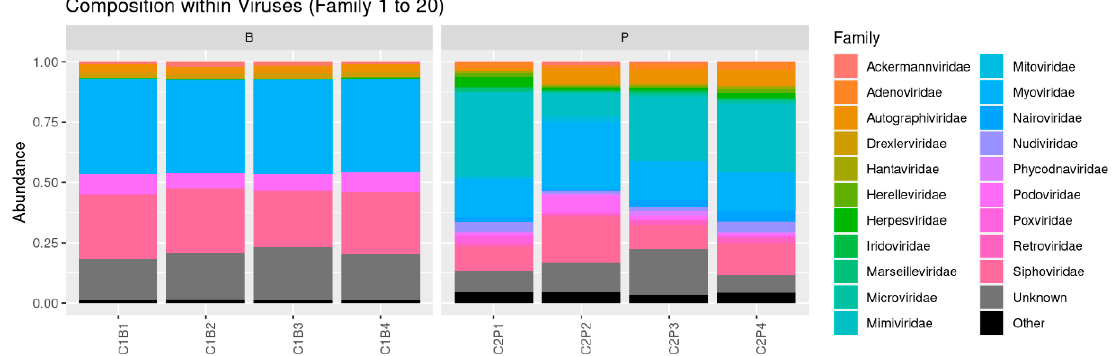
Figure 2. Virus taxonomic assignations at the family level during cider fermentation process for two producers (B: industrial and P: hand-crafted). C1 and C2 indicate the tank ID, and B1, B2, B3, B4, P1, P2, P3 and P4 are the sampling points during the fermentation process, in reference to Table 1.